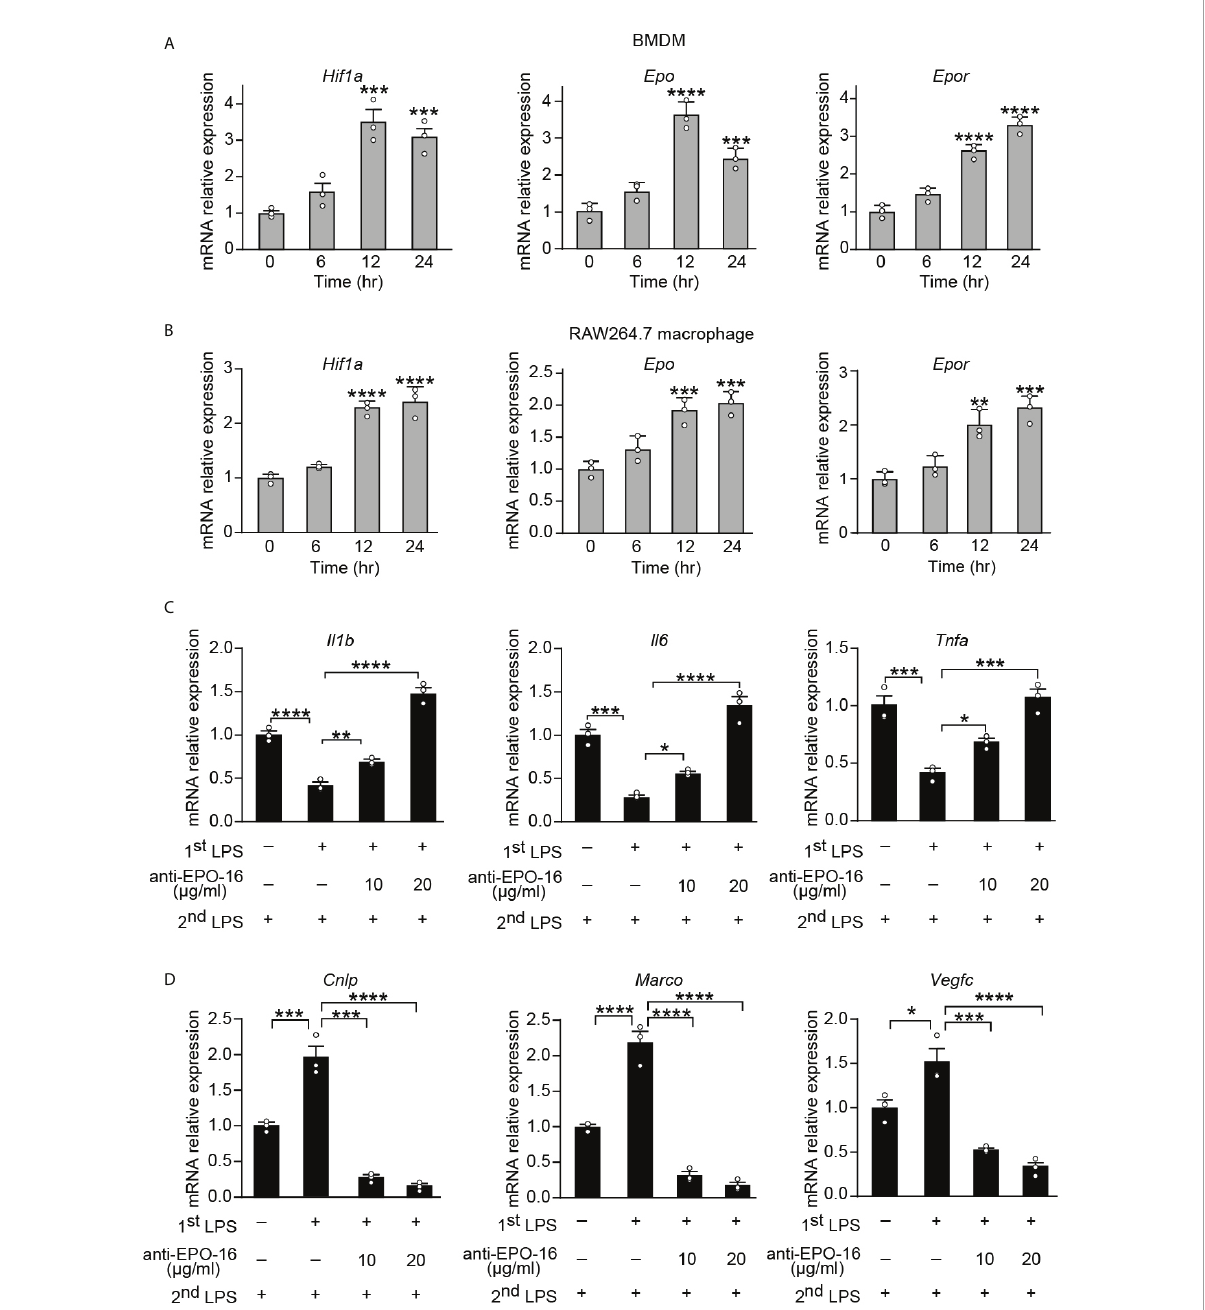
FIGURE 1 Blockade of endogenous EPO impaired re-programming of endotoxin-tolerant macrophages. (A, B) : In vitro cultured BMDMs from WT C57BL/6 mice (A) or mouse RAW264.7 macrophages (B) were incubated with LPS (100 ng/ml) for 0, 6, 12, and 24 h, and mRNA levels of Hif1a , Epo , and Epor in macrophages were measured by qRT-PCR (n = 3). ( C , D) : In vitro cultured RAW264.7 macrophages were pretreated with PBS (non- tolerant), LPS (100 ng/ml) (tolerant), or LPS (100 ng/ml) + anti-EPO-16 (10 or 20 m g/ml) for 24 h. Then, cells were washed with PBS twice. Subsequently, cells were given with a secondary LPS stimulation (10 ng/ml) for 6 h, and the mRNA levels of Il1b , Il6 , Tnfa (C) , Cnlp , Marco , and Vegfc (D) were measured by qRT-PCR (n = 3). Data are representative of three independent experiments. Results were expressed as means ± SEM. *P < 0.05, **P < 0.01, ***P < 0.001, and ****P < 0.0001 (one-way ANOVA with Tukey ’ s post-hoc test for multiple